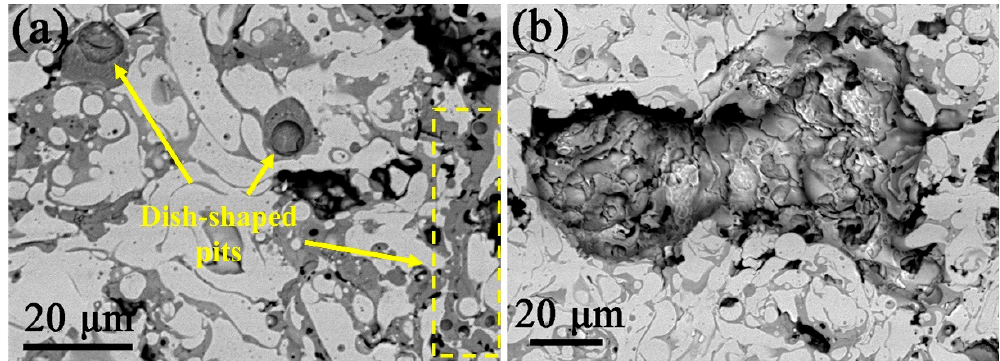
Figure 7. SEM images of corrosion morphology after electrochemical test: ( a ) dish-shaped pitting pits, ( b ) a large corrosion pit.